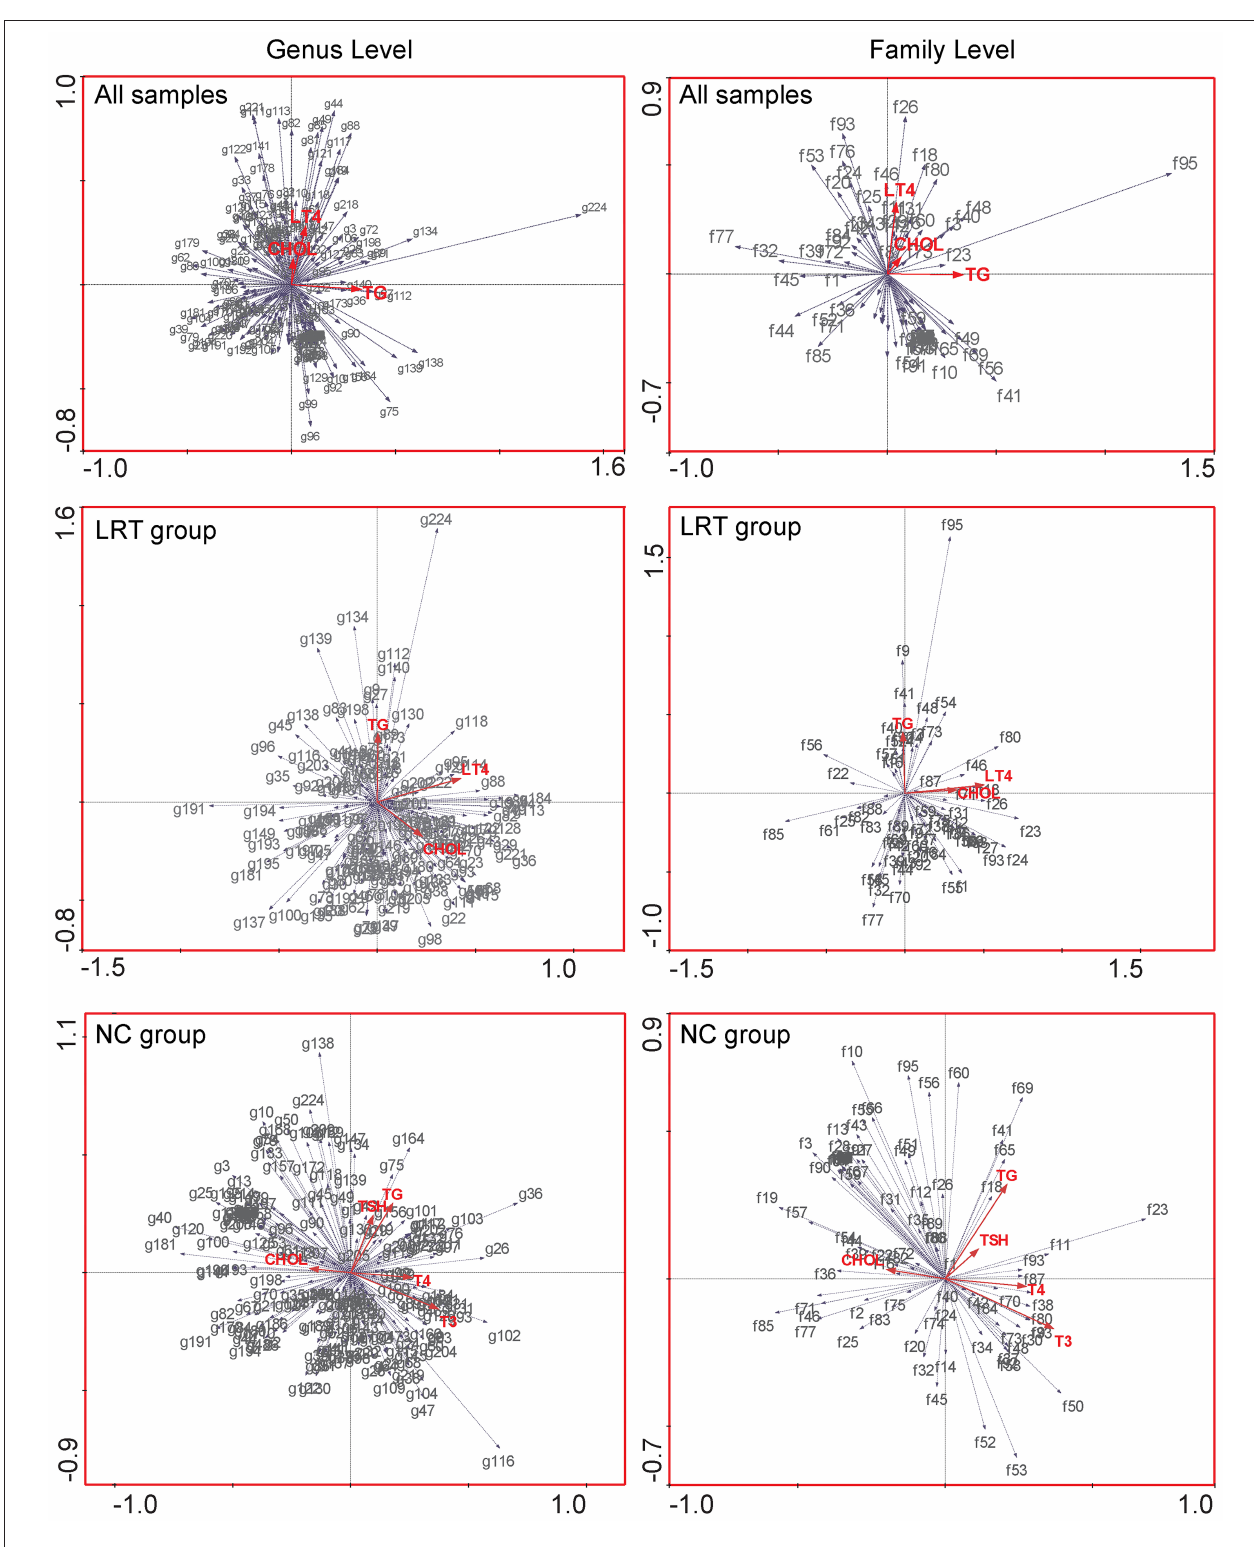
FIGURE 6 | Canonical correspondence analysis (CCA) was used to evaluate the possible association of gut microbes with environmental factors, in all samples (upper row), LRT groups (middle row), and NC group (lower row), respectively. The red arrows in the figure represent different environmental factors, gray arrows were set pointing to species, and the length of the gray arrows quantitatively indicated the correlation significance between certain species and environmental factors. The angle between any two arrows is representative of the correlation between certain species or species and environmental factors. The acute angle indicates positive correlation, and the obtuse angle is a negative